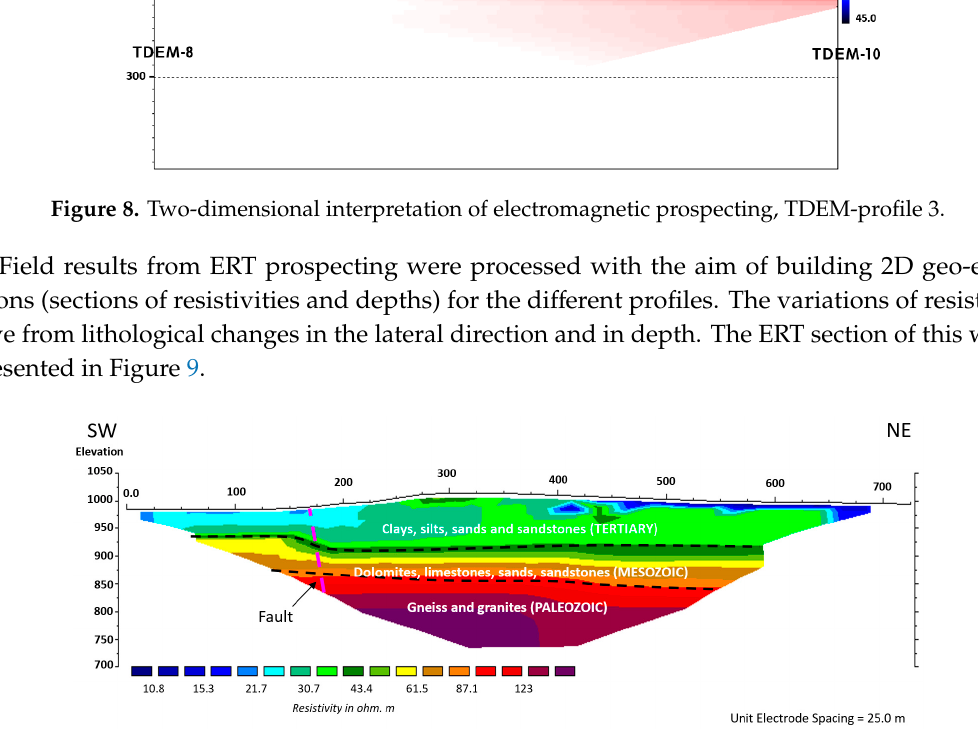
Figure 9. Two-dimensional resistivity section from the ERT profile in the area under study.